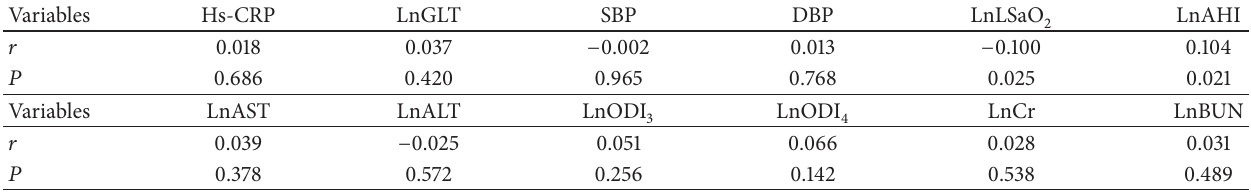
Table 2: Relationship between serum LnTSH and TSH risk factors and polysomnographic measures controlled for age, gender, and BMI. Variables Hs-CRP LnGLT SBP DBP LnAHI